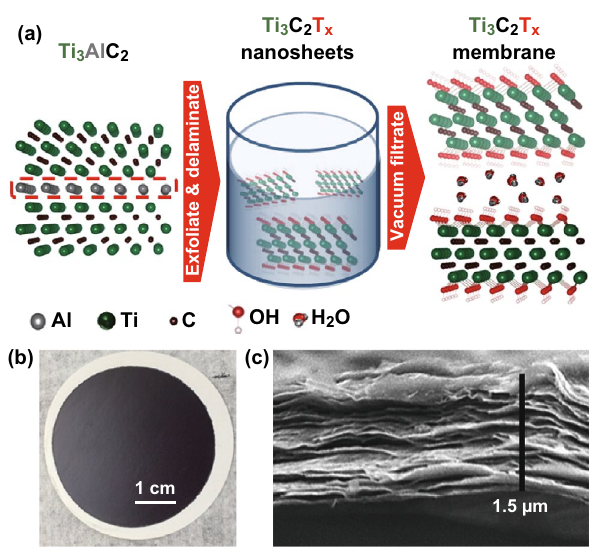
Fig. 2 a A schematic of the synthesis of a Ti 3 C 2 T x membrane, b pho- tograph, and c SEM image of cross-sectional of the Ti 3 C 2 T x mem- brane. Reprinted with the permission from Ref. [36]. Copyright © (2015) American Chemical Society